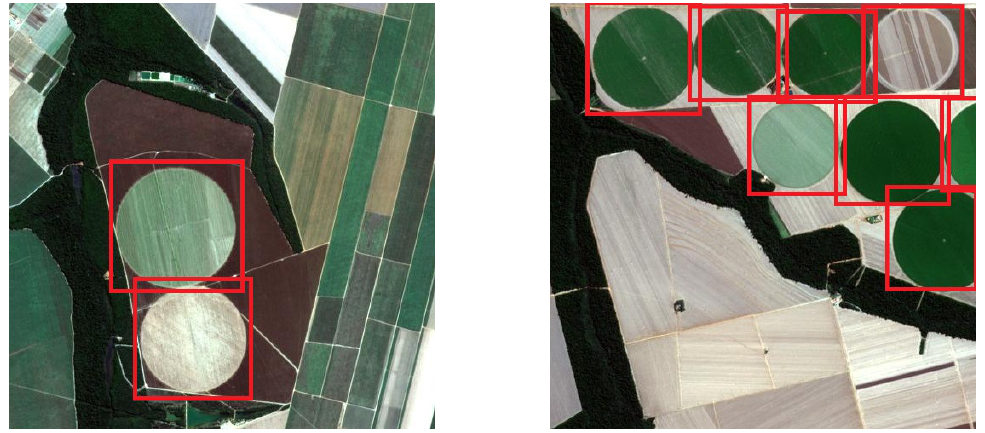
Figure 7. Examples of training samples for PVANET.